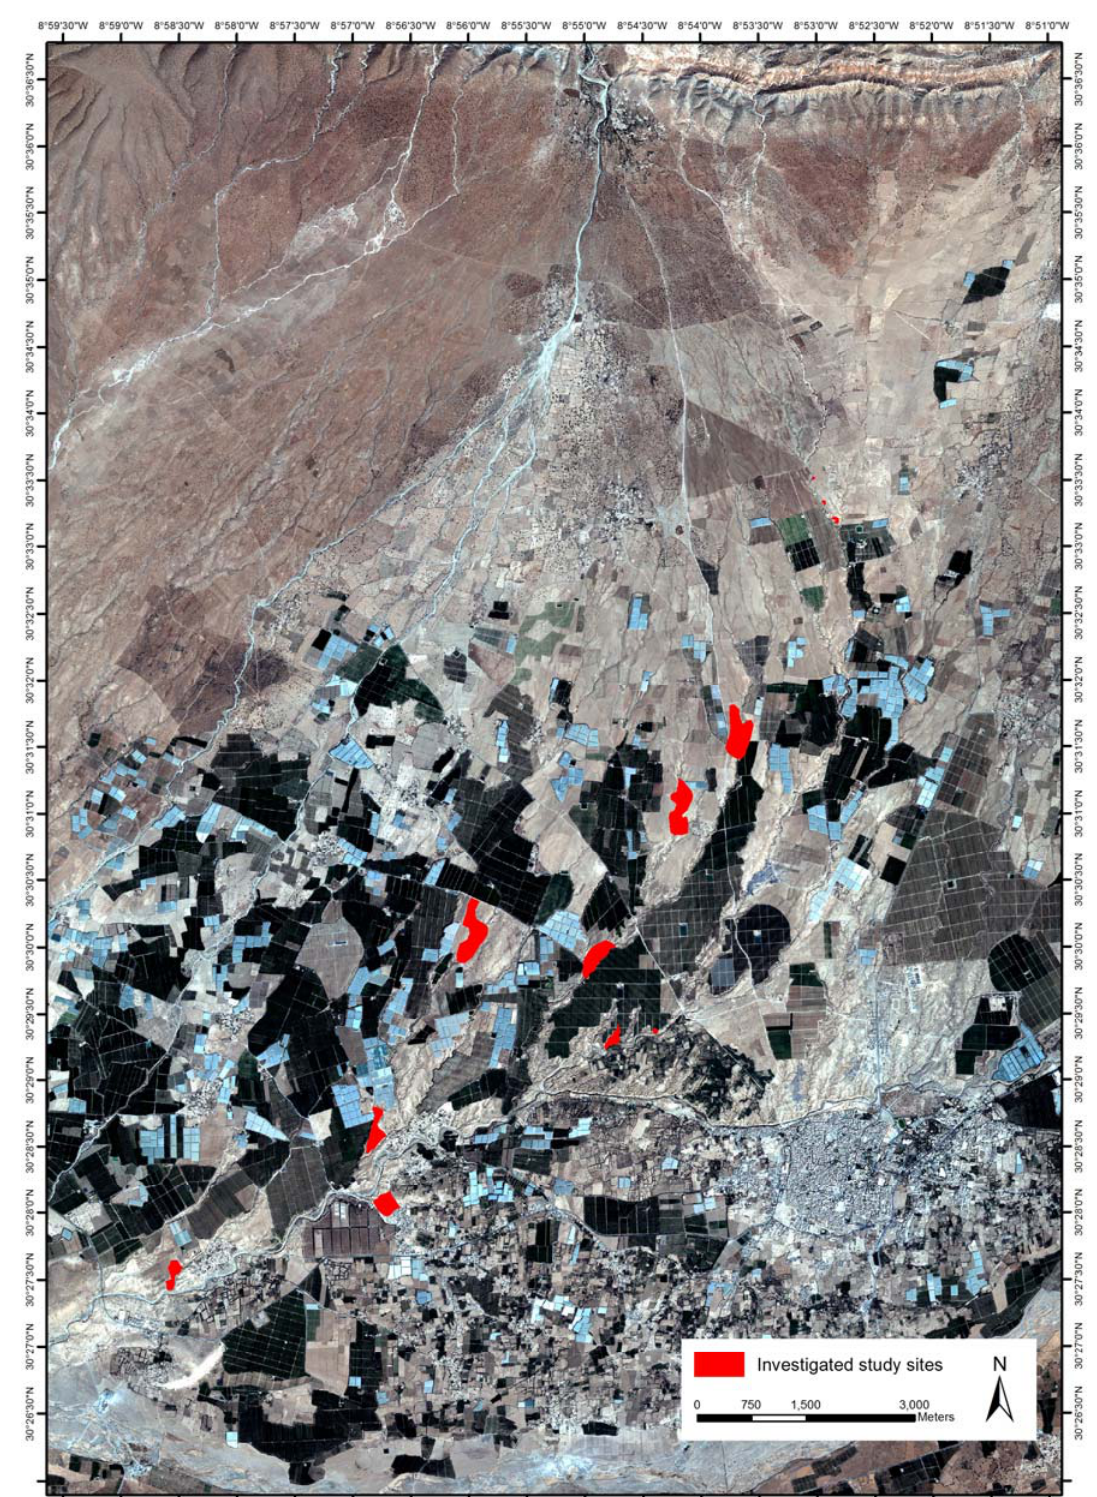
Figure 2. Overview of the study area with investigated gully sites. The dark-green patterned areas are fruit-tree plantations; the light-blue, mostly rectangular shapes are greenhouses. The city of Taroudant is situated in the lower right and surrounded by less industrialized, more fractured agricultural areas (Quickbird2; 26 October